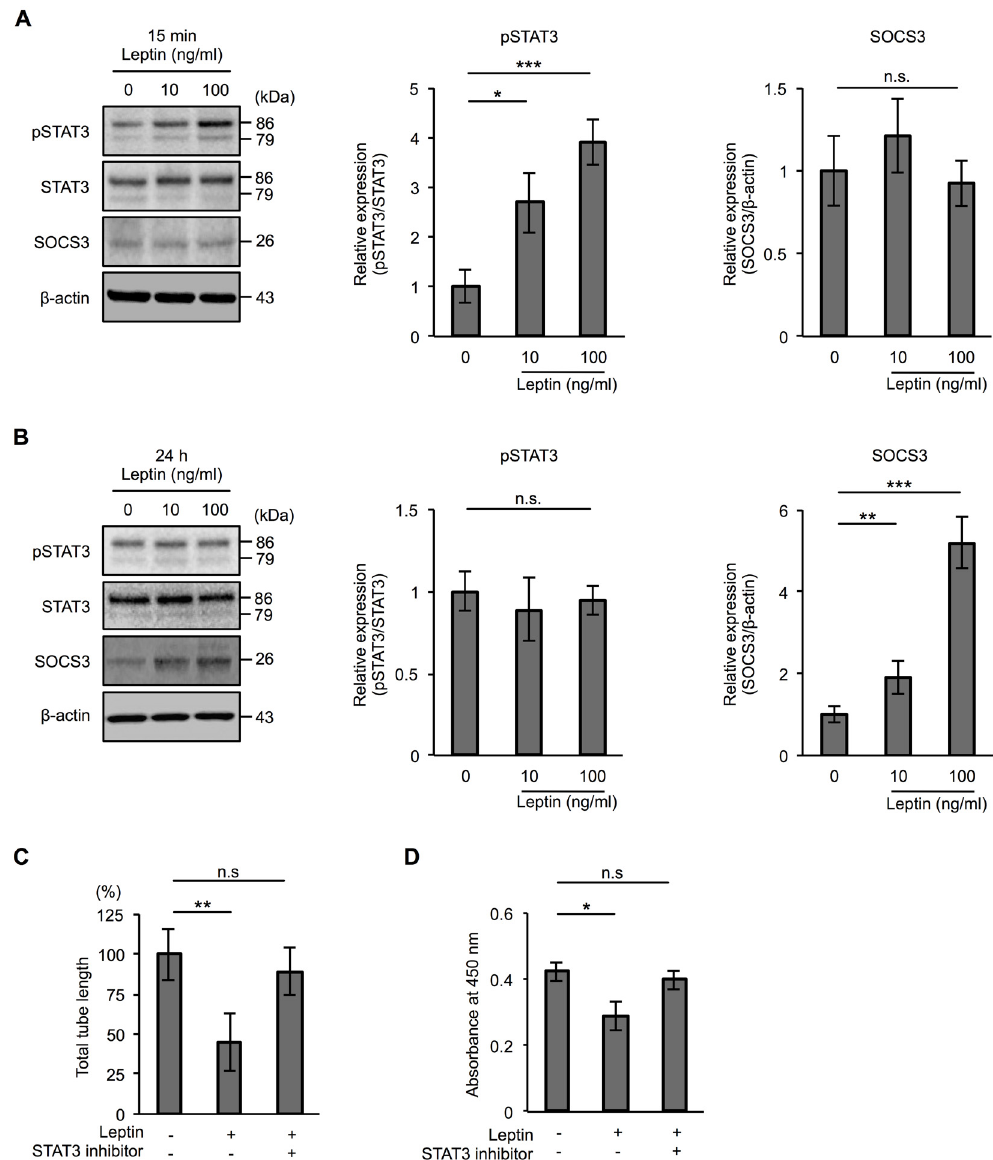
Fig 6. Leptin regulates STAT3 phosphorylation and SOCS3 expression in human lymphatic endothelial cells. Immunoblot analysis of pSTAT3 (Y705), STAT3 and SOCS3 in HDLECs exposed to 10 or 100 ng/ml leptin for 15 min ( A ) and 24 h ( B ). β -actin was used as a loading control. Histograms represent relative expression of pSTAT3 and SOCS3 proteins in HDLECs exposed to 10 or 100 ng/ml leptin for 15 min ( A ) and 24 h ( B ) as determined by densitometry analysis. Results are expressed as means ± SEM of four independent experiments; * p < 0.05, ** p < 0.01, *** p < 0.001, t -test. n.s.: not significant. ( C ) Histograms represent total tube length in HDLECs exposed to leptin (100 ng/ml) for 17 h with or without 250 nM STAT3 inhibitor. Total tube length and mean length in each condition were measured using Image J software. Results are expressed as means ± SEM of four independent experiments; ** p < 0.01, t -test. n.s.: not significant. ( D ) WST-8 assay showing proliferation of HDLECs treated with leptin (100 ng/ml) for 17 h with or without 250 nM STAT3 inhibitor. Histograms represent absorbance at 450 nm. Results are expressed as means ± SEM of four independent experiments; * p < 0.05, t -test. n.s.: not significant. ( C and D ) STAT3 inhibitor was added 30 min prior to leptin treatment.